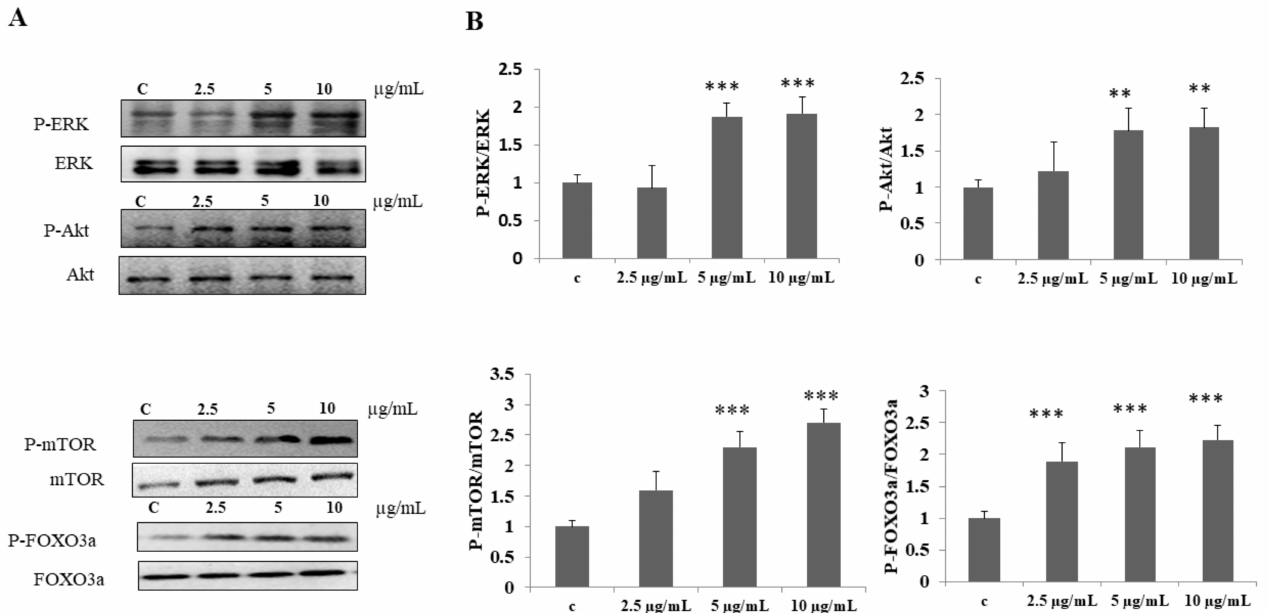
Figure 2. DI-10 activates ERK, Akt, mTOR, and FOXO3a proteins and facilitates protein synthesis in myoblast cells. Dose-dependent activation of ERK, Akt, mTOR, and FOXO3a was observed in myoblast cells after DI-10. ( A ) Western blotting show phosphorylation of ERK, Akt, mTOR, and FOXO3A in C2C12 cells after DI-10 treatment. ( B ) Graph showing densitometric analysis. *** p < 0.001, and ** p < 0.01 compared to control